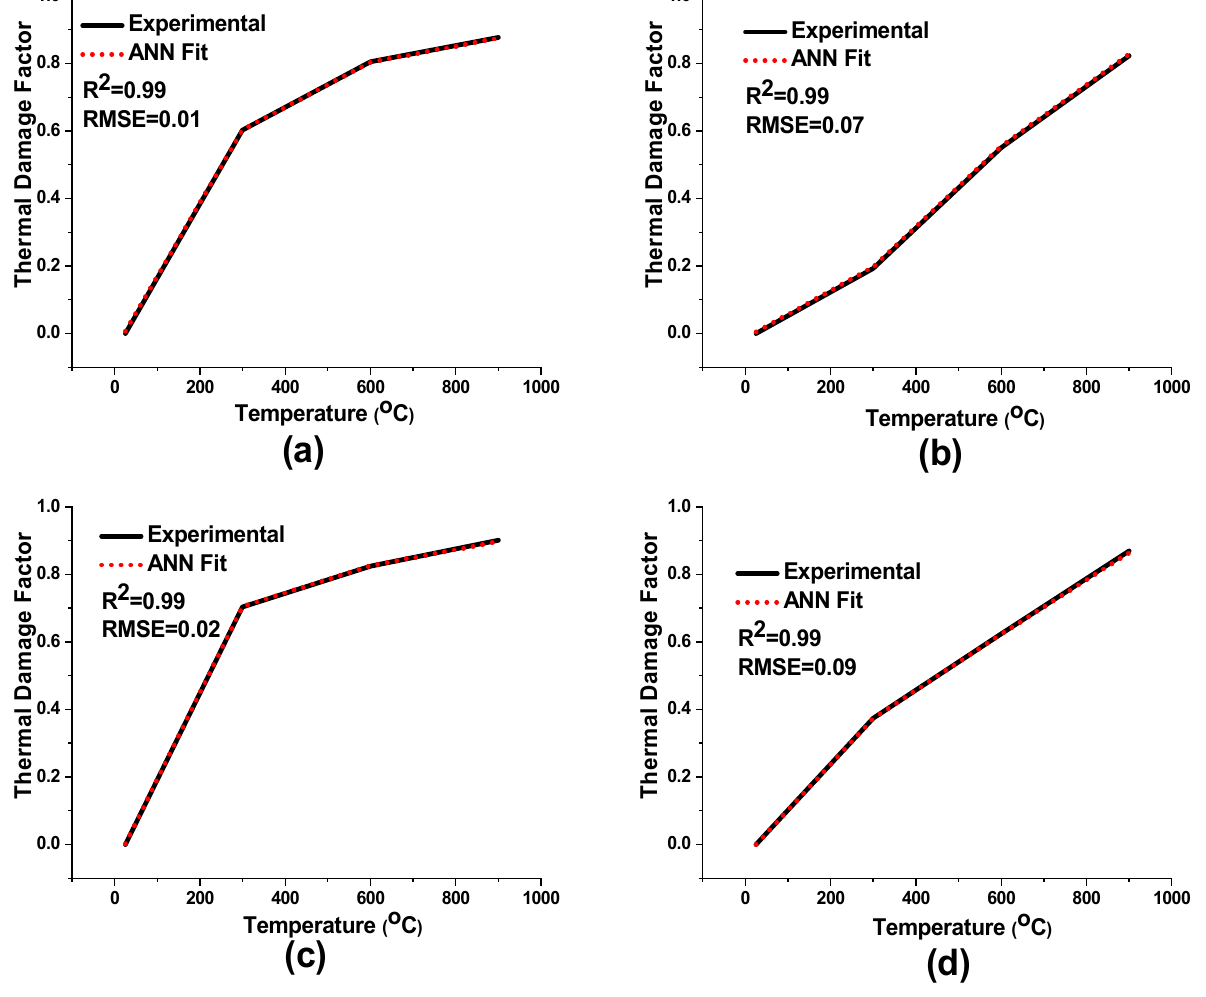
Figure 8. Experimental ANN model; ( a ) porosity-based D T under slow cooling, ( b ) elasticity-based D T under slow cooling, ( c ) porosity-based D T under rapid cooling, and ( d ) elasticity-based D T under rapid cooling.